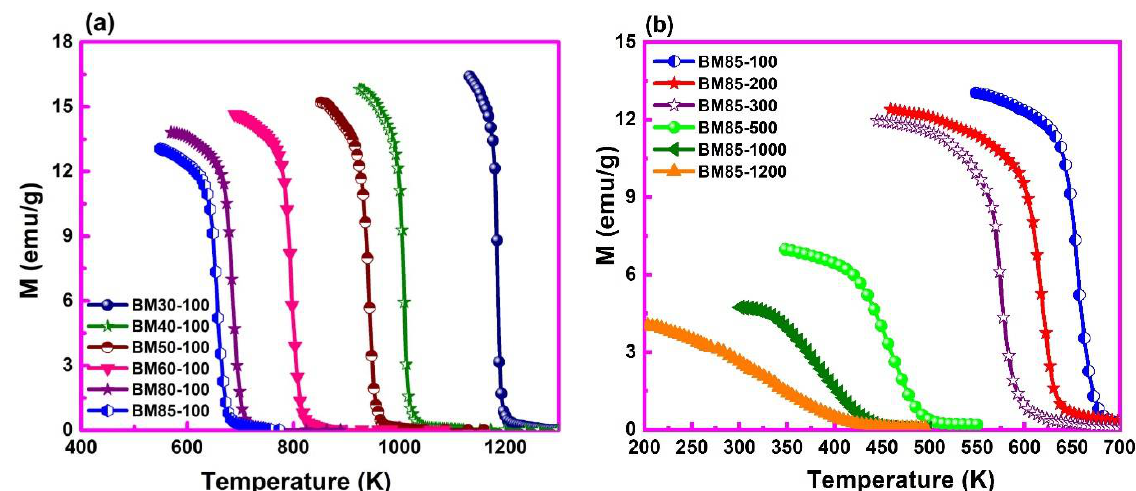
Figure 9. Zero-field-cooled thermal-demagnetization measurements of ( a ) Co 100−x Ni x NPs milled for 100 min and ( b ) Co 15 Ni 85 NPs milled for 200, 300, 500, 1000, and 1200 min in a measuring field of 150 Oe.